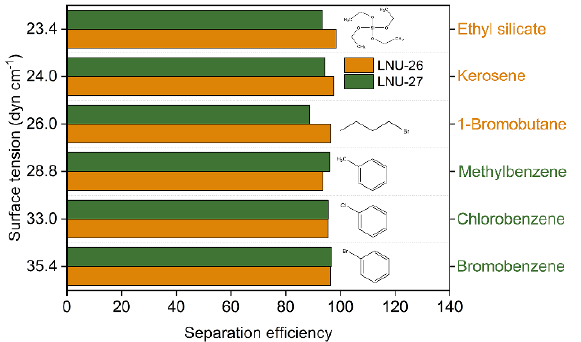
Figure 4. Separation efficiency of PAF-solid-coated fabric for different polarities of organic solvents and oils.